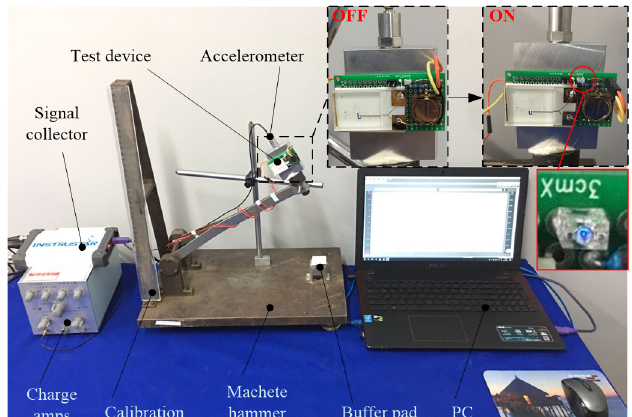
Figure 6. Custom-built machete hammer system. Table 2. Structure parameters of the test device (µm).